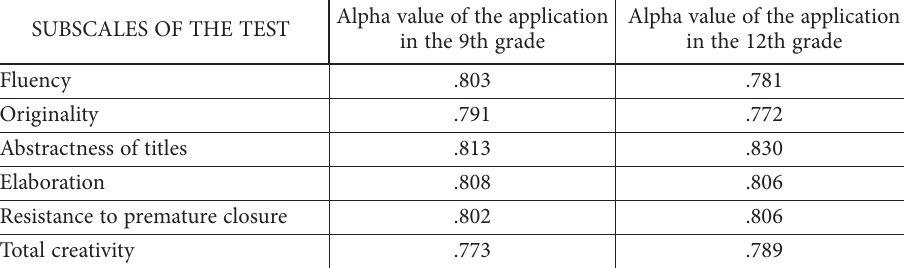
Table 2. Torrance Test of Creative Thinking (Figural Form A’s) reliability test results (source: created by